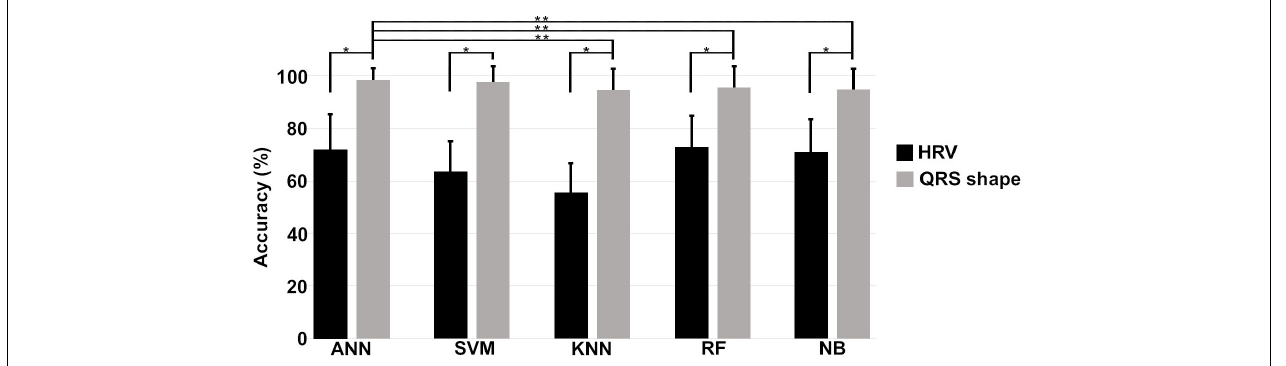
FIGURE 6 | Means and standard deviations of the prediction accuracies of each algorithm. Single asterisk ( ∗ ) indicates a statistically significant difference between prediction accuracies using HRV and QRS shape features (QRS > HRV, p < 0.001), and double asterisk ( ∗∗ ) between the prediction accuracies of different algorithms (ANN = SVM > KNN, RF, and NB, p < 0.001). HRV: heart rate variability with 11 parameters, QRS shape: QRS signed area and R-peak amplitude with 4 parameters, ANN: artificial neural network, SVM: support vector machine, KNN: k-nearest neighbors, RF: random forest, NB: Gaussian Naïve